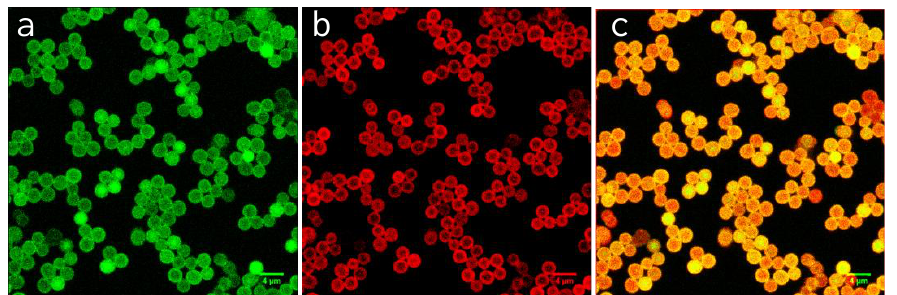
Figure 5. Confocal microscopy images of SiO 2 @calcein@P2VP- b -PEO@TA@PS 10 -PEO 10 /Nile Red particles. In image ( a ), the green color from calcein is shown (excitation 495 nm/emission 519 nm). In image ( b ), the red color from Nile Red (excitation 550 nm/emission 573 nm) is shown. Image ( c ) is the merged image of green ( a ) and red ( b ) calcein and Nile Red, respectively. Scale bars: 4 μm.